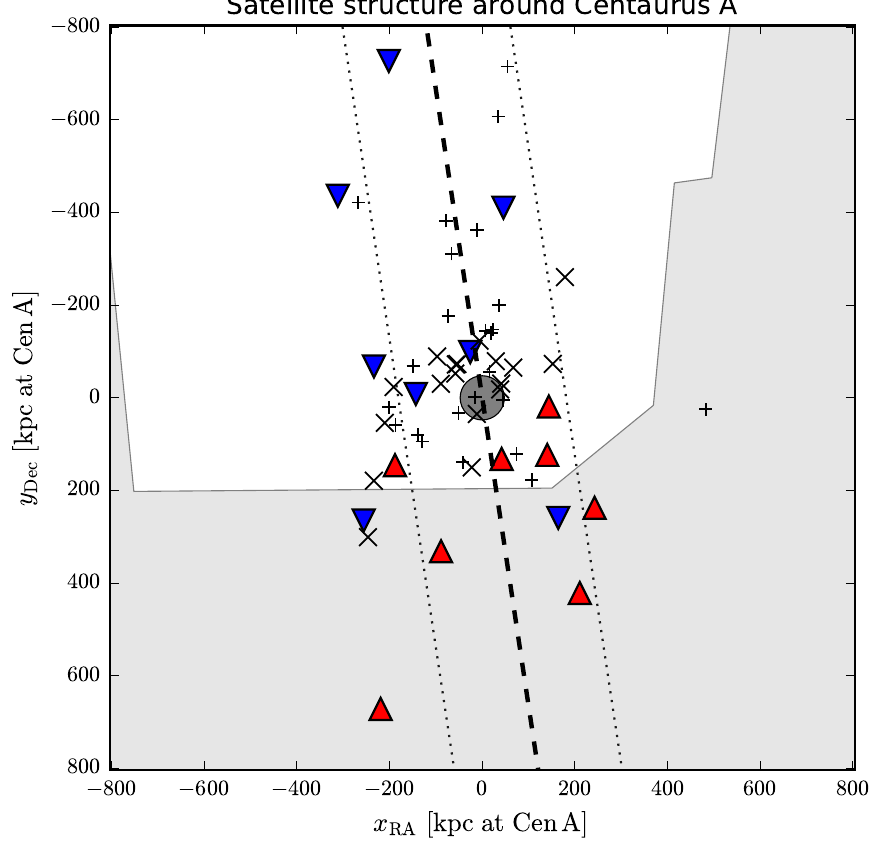
Figure 14. The Centaurus A satellite plane (CASP) and the Centaurus A disk (dark grey circle at the center) as viewed from the Sun. The orientation and the width of the best-fit satellite plane are indicated by the dashed and dotted lines, respectively. The colored triangles, red upward (blue downward) for receding from (approaching towards) an observer at rest with respect to the host galaxy, indicate coherent kinematics of the co-orbiting satellites. The grey area show the volume outside the survey. The figure is reproduced from